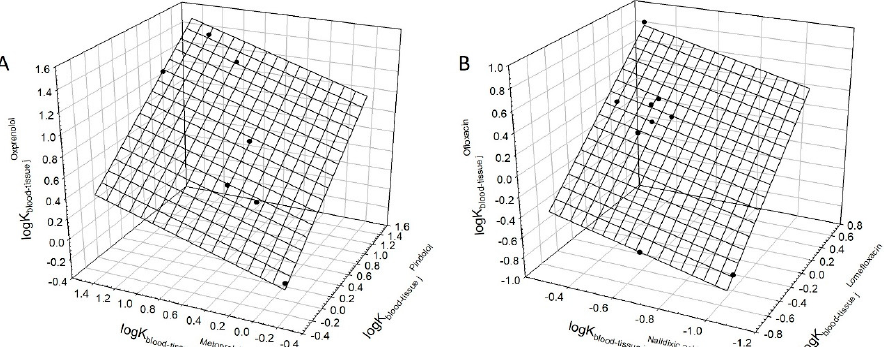
Figure 4. ( A ) Linear relationship between logarithms of partition coe ffi cients of pindolol, metoprolol,